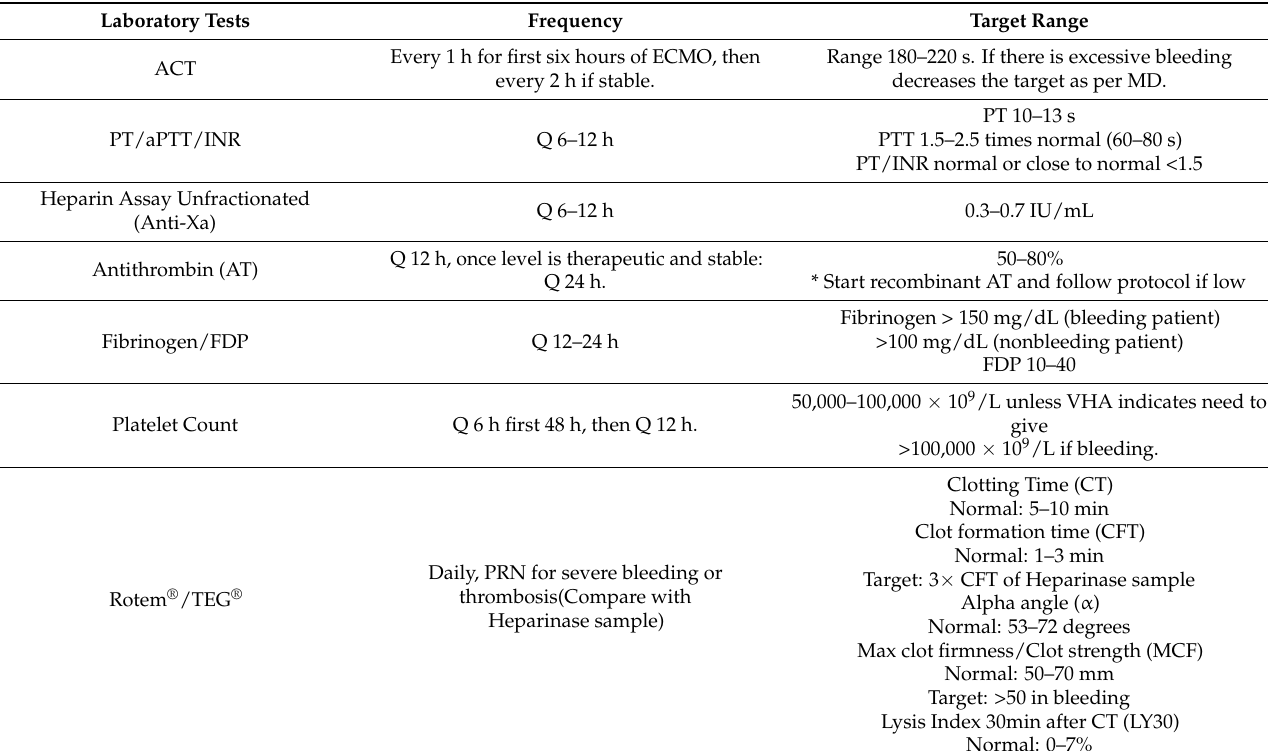
Table 3. Extracorporeal membrane oxygenation (ECMO) anticoagulation laboratory monitoring protocol